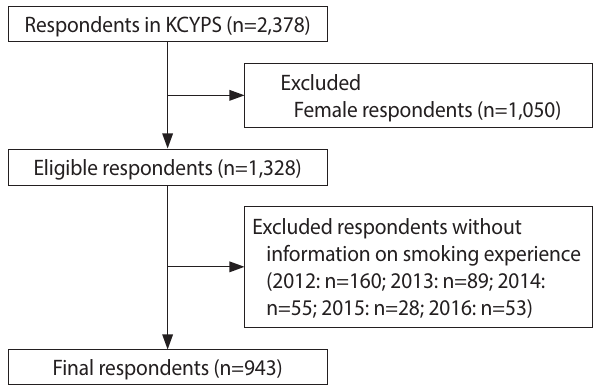
Figure 1. The selection process of respondents included in the final analysis. KCYS, Korean Children & Youth Panel